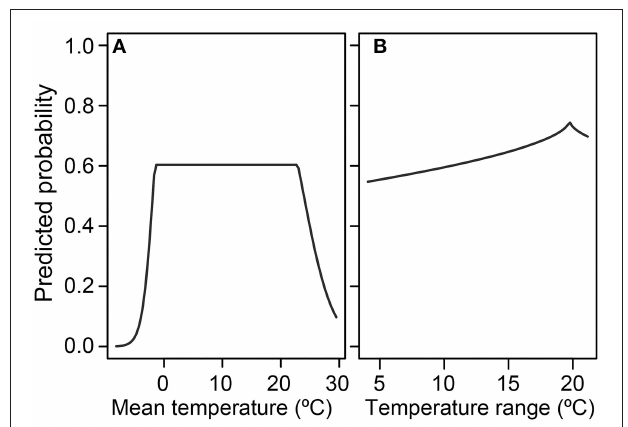
FIGURE 5 | Absolute probability of Batrachochytrium dendrobatidis ( Bd ) occurrence for the environmental attributes (A) mean temperature and (B) temperature range from the global presence-absence best-fit species distribution